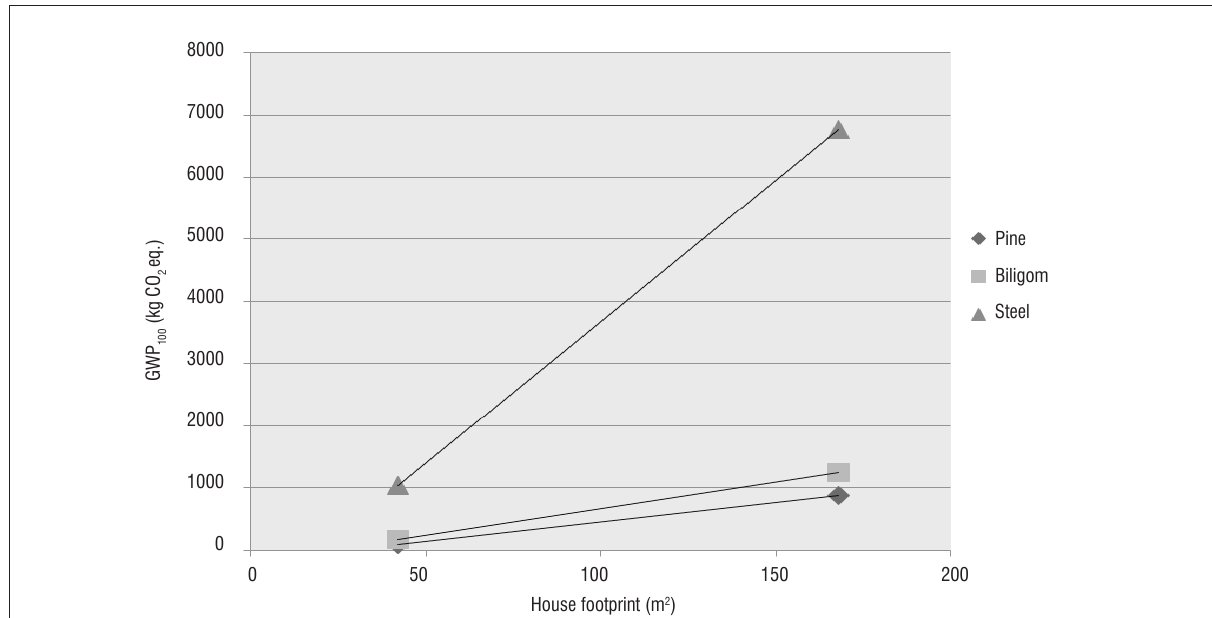
Figure 1: Global warming potential (GWP) gradient for South African pine, Biligom and light gauge steel for 42-m 2 and 168-m 2